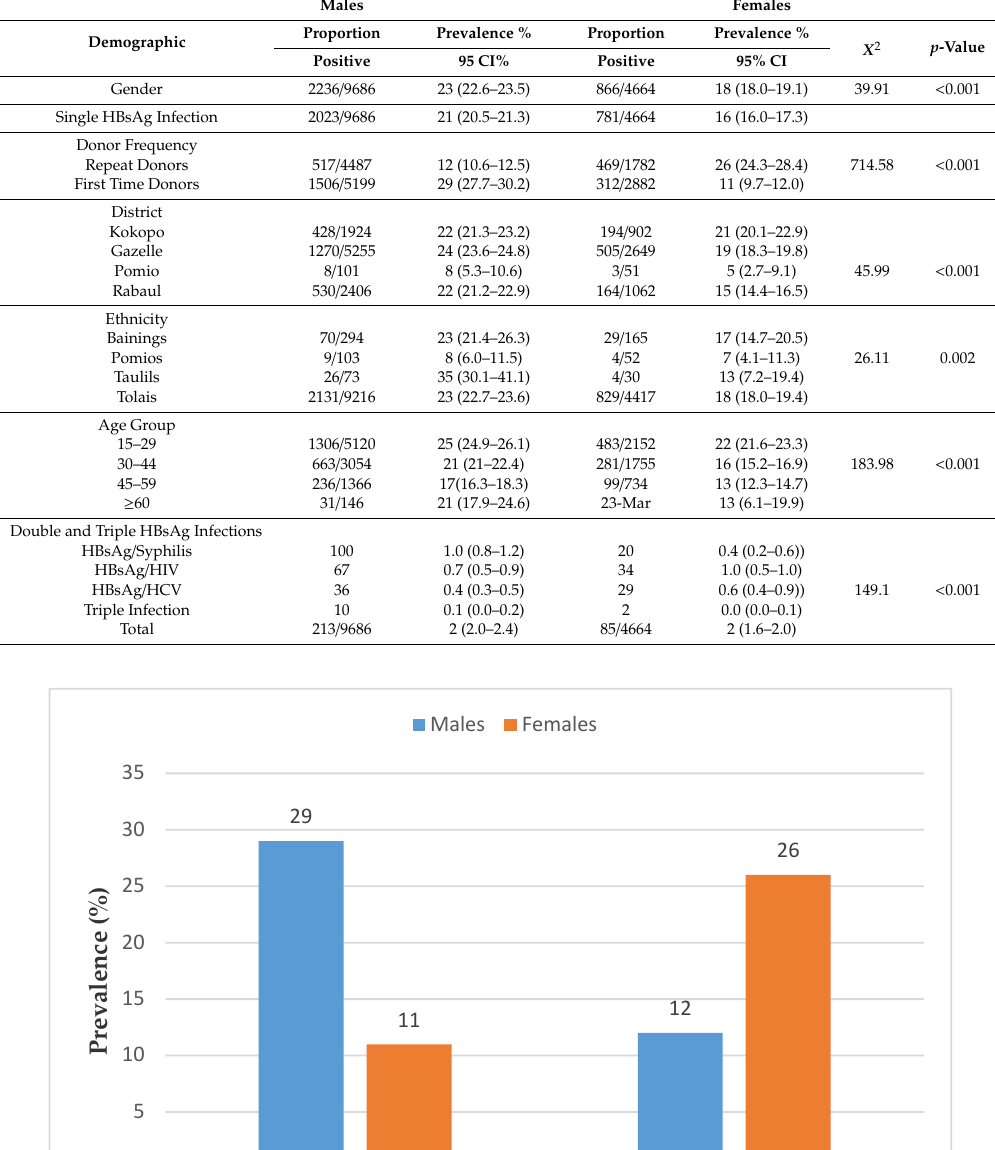
Table 2. Mean prevalence rates of HBsAg by gender for single and co-infections among districts, ethnic groups and age groups in East New Britain province between 2003–2018.